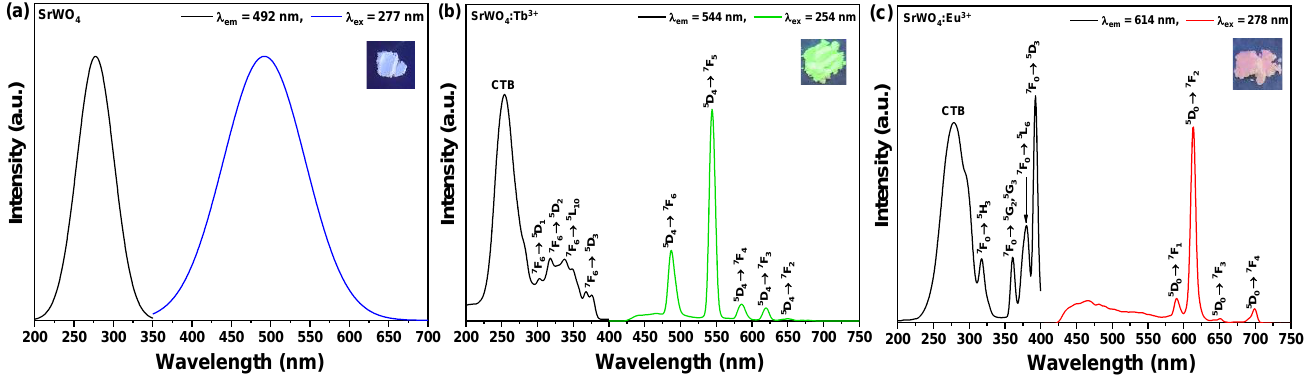
3+ , and ( c ) SrWO 3+ samples. 4 :Eu 4 , ( b ) SrWO 4 :Tb